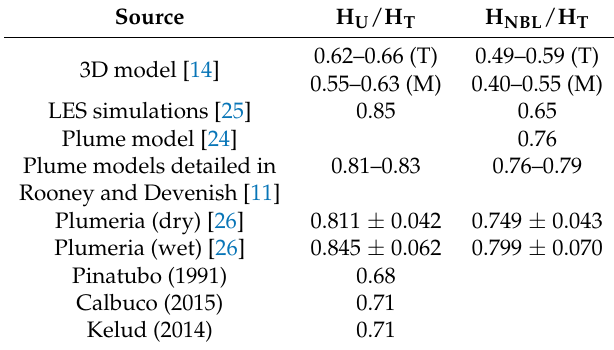
Table 1. Ratios of H U / H T and H NBL / H T obtained using various plume models and from some historic eruptions. The Plumeria values are given as the mean ± one standard deviation and H U is taken to be the equilibrium height of the downwind plume (the Plumeria simulations do not model an umbrella cloud). For the Suzuki and Koyaguchi [14] simulations, “T” and “M” refer to tropical and midlatitude atmospheres, respectively. Source H U / H